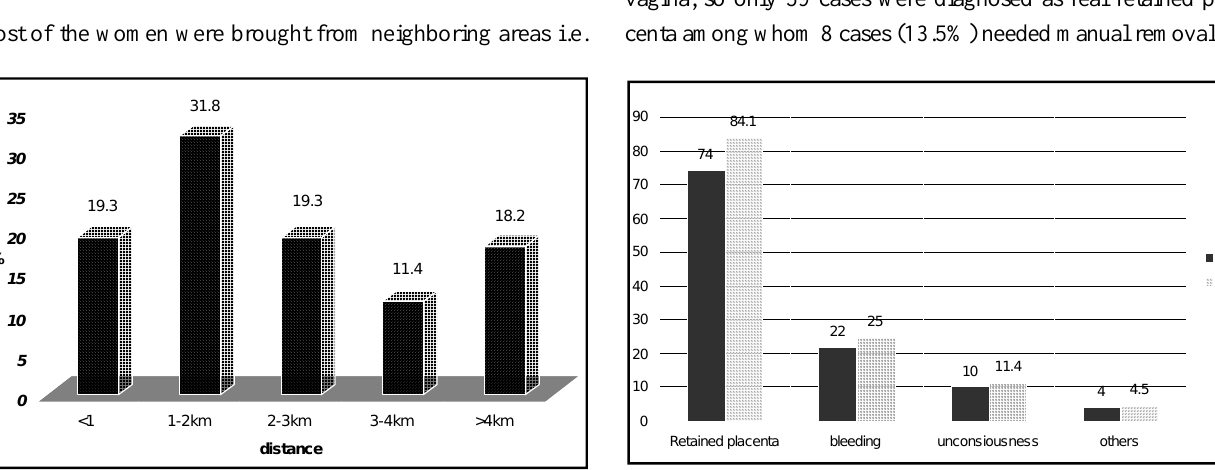
Fig.1 : Distance from hospital to residence of the women Fig.2 : Reason for attending hospital Table II : Fetal outcome